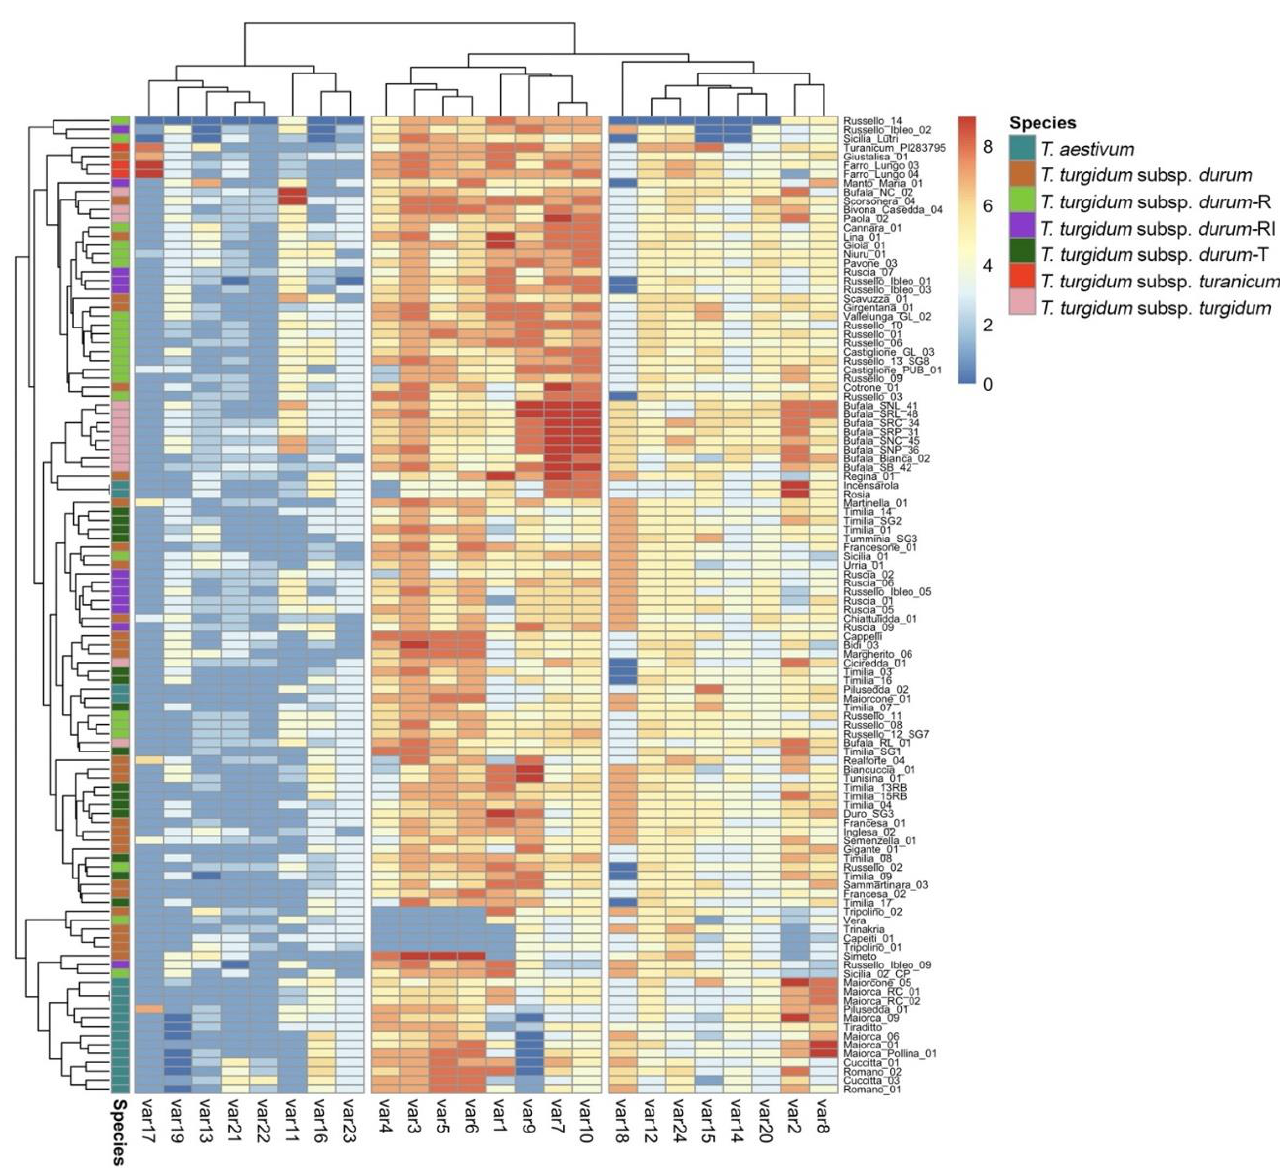
Figure 3. Heatmap of the morphological traits evaluated on a wheat germplasm subset (110) (Table S3). R: ‘Russello’; RI: ‘Russello Ibleo’; T: ‘Timilia’. The colors in the heatmap indicate the values reported in Table S4 for each trait